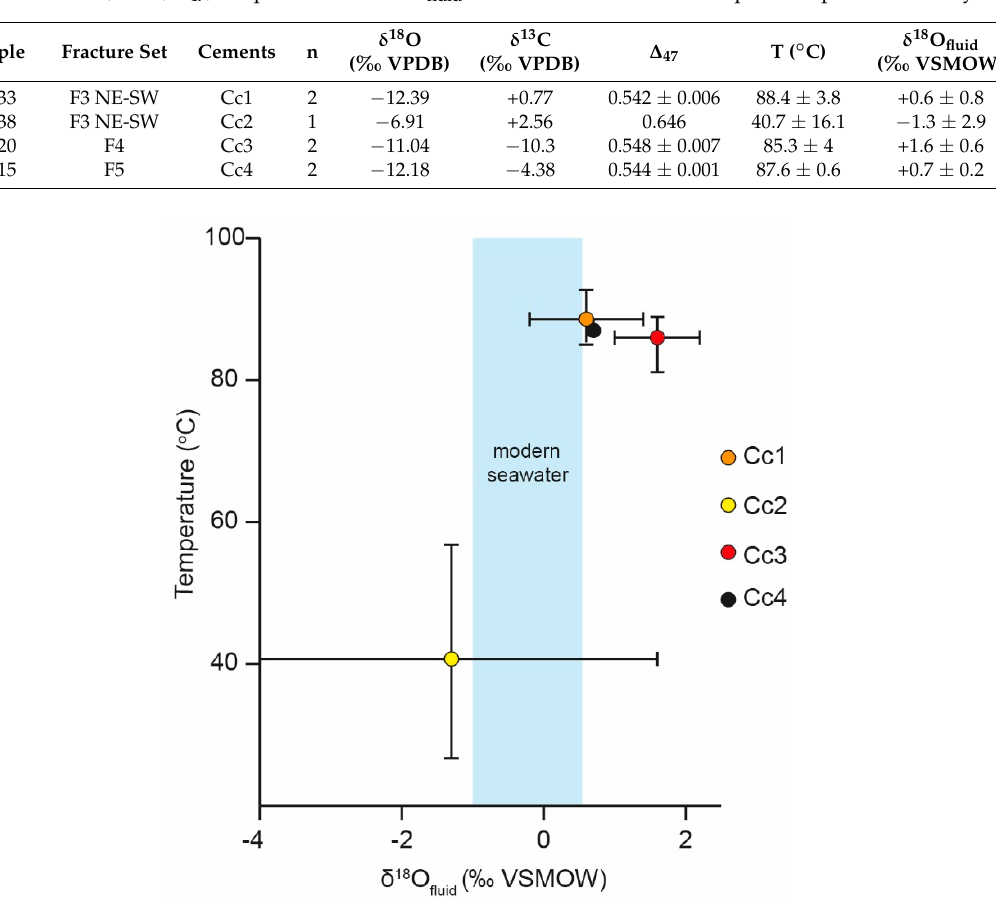
Figure 12. Temperatures ( ◦ C) vs δ 18 O ( ‰ VSMOW) calculated for fluids from which the different generations of calcite cements precipitated using clumped isotope geochemistry. The blue box represents δ 18 O average values for modern seawater [91].